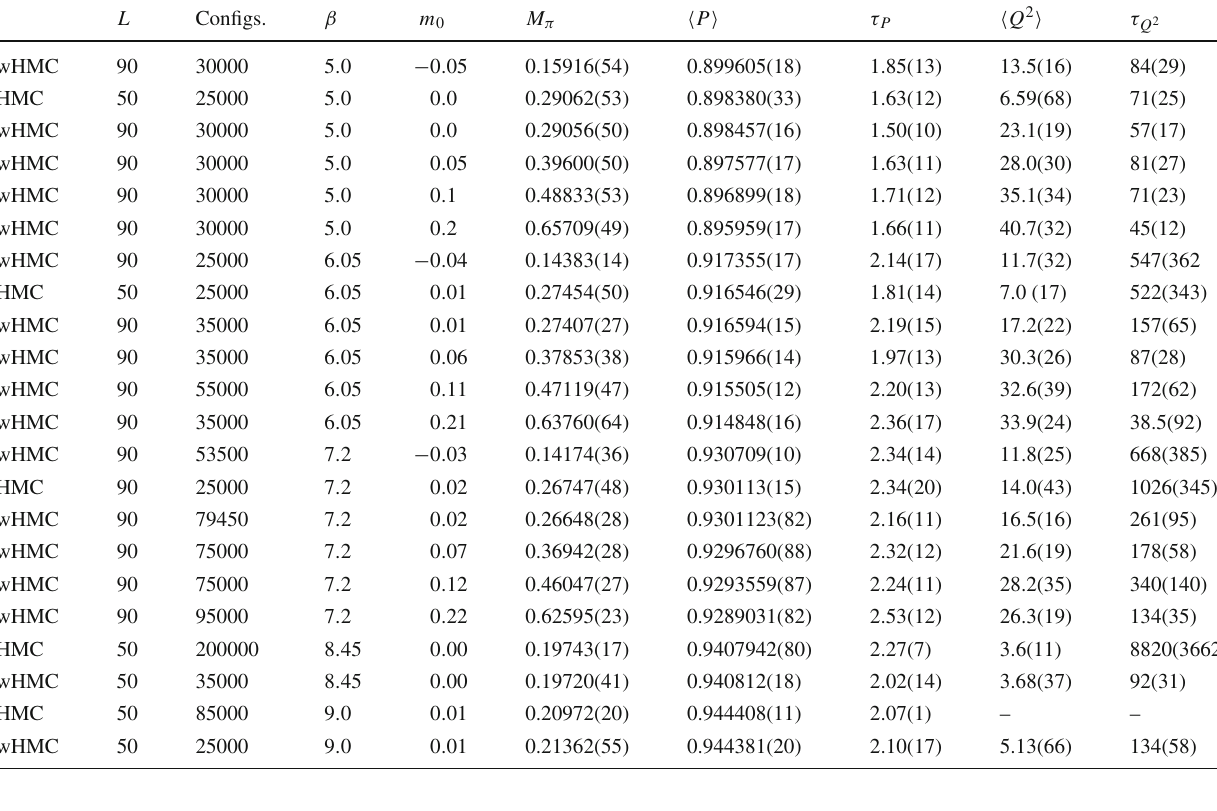
Table 2 Simulation parameters and results from the N f = 2 simulations